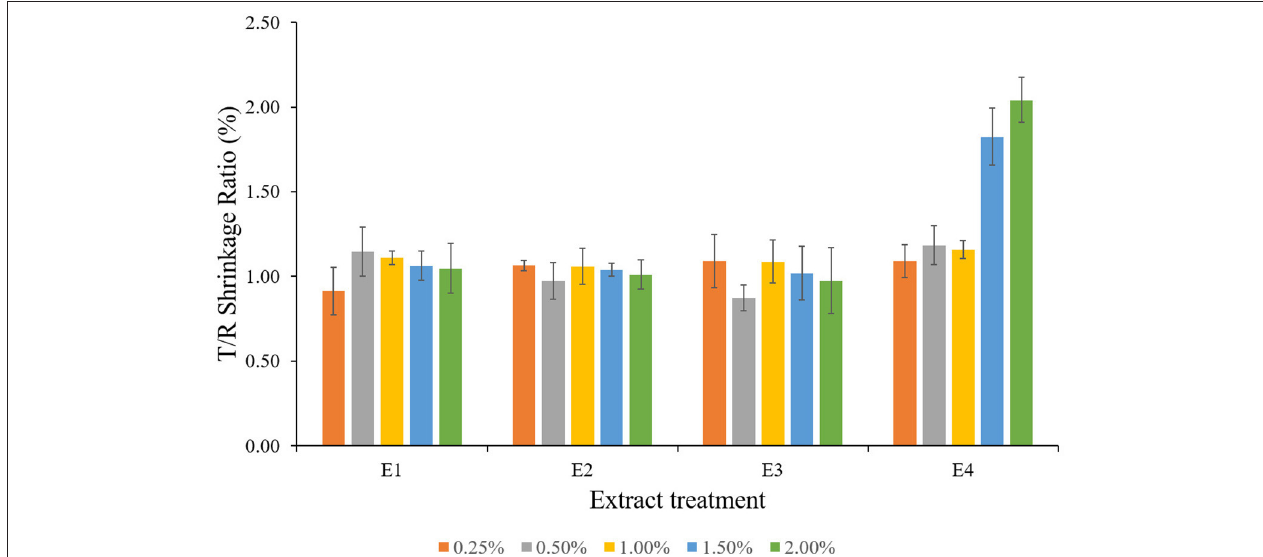
FIGURE 5 | Tangential-radial shrinkage ratio (T/R) of plant extract treated wood blocks of Lannea coromandelica .